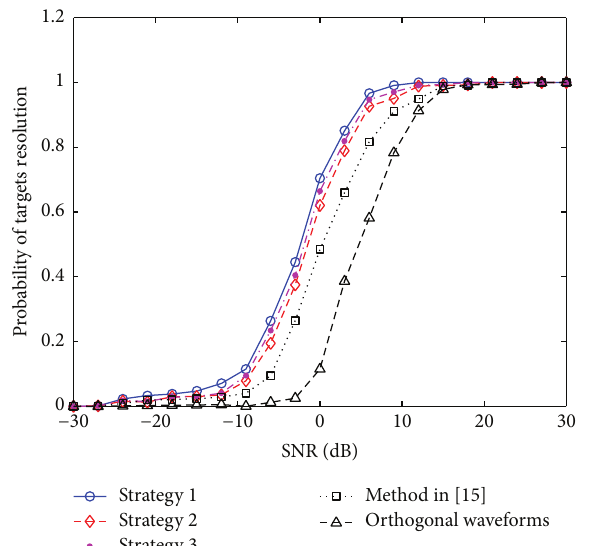
Figure 4: Transmit beampatterns of the orthogonal waveforms, method in [15], and the proposed strategies in Example